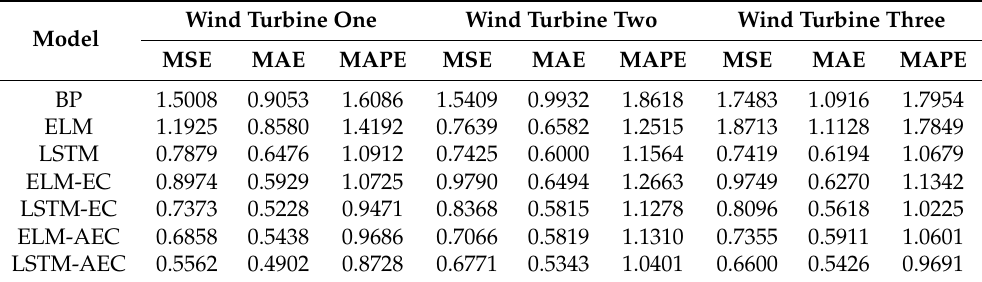
Table 2. Performance evaluations of different models for gearbox oil temperature prediction. Model